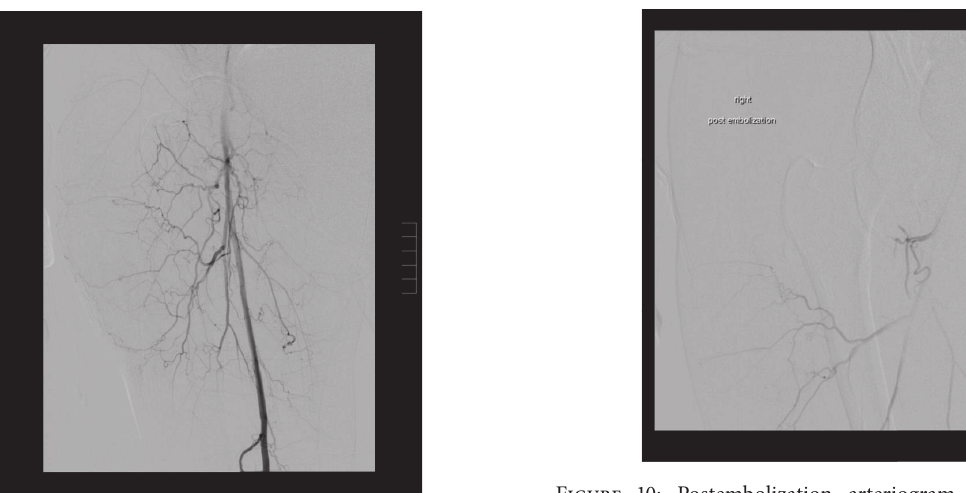
Figure 10: Postembolization arteriogram confirms successful